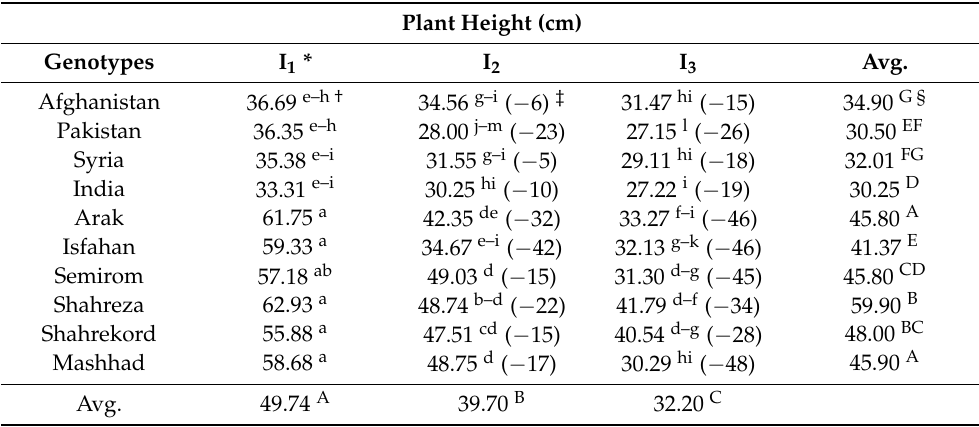
Table 9. Mean comparison of the effect of irrigation regime (I), genotype (G), and their interaction on plant height of black